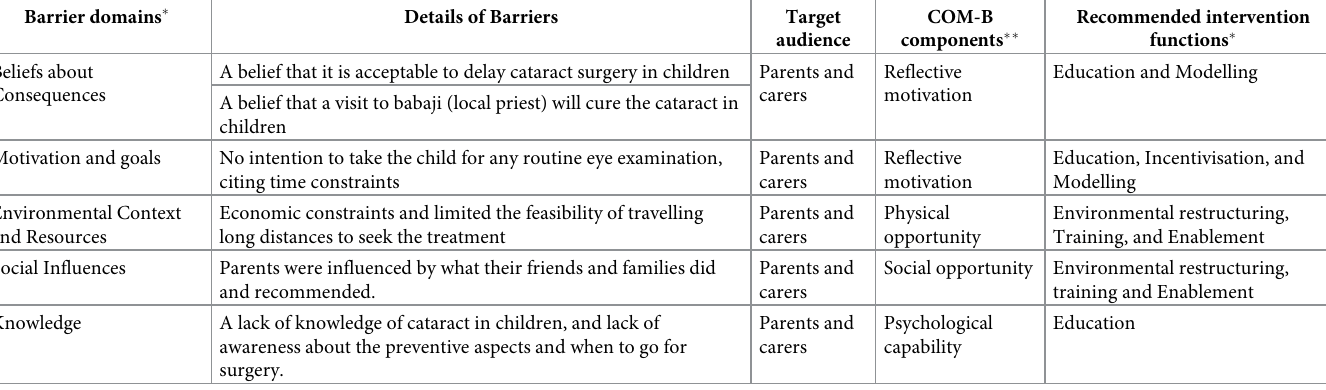
Table 1. Recommended intervention functions for increasing the timely uptake of childhood cataract services in India. Barrier domains